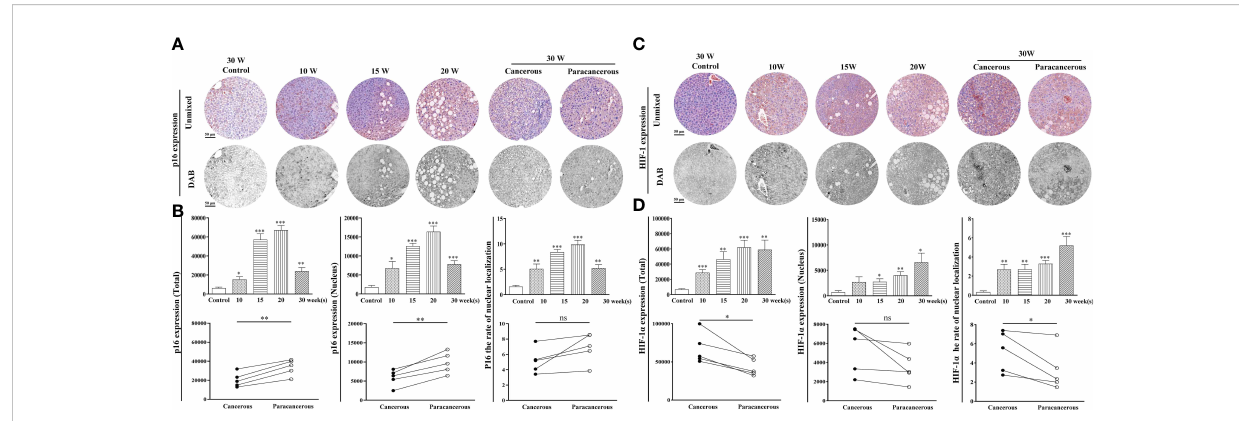
FIGURE 4 Immunohistochemical staining of p16 and HIF-1 a proteins in mouse livers at different time points and their quantitative representative images. (A) Representative images of immunohistochemical staining of p16 in mouse livers during liver carcinogenesis. (B) Quantitative multispectral image of the p16 protein. (C) Representative images of immunohistochemical staining of HIF-1 a in mouse livers during liver carcinogenesis. (D) Quantitative multispectral image of the HIF-1 a protein. The experimental data are expressed as the mean ± SEM. Compared to the control, * p < 0.05; ** p < 0.01; *** p < 0.001. Compared to paracancerous regions, * p < 0.05. Scale bar, 50 µm. ns, not